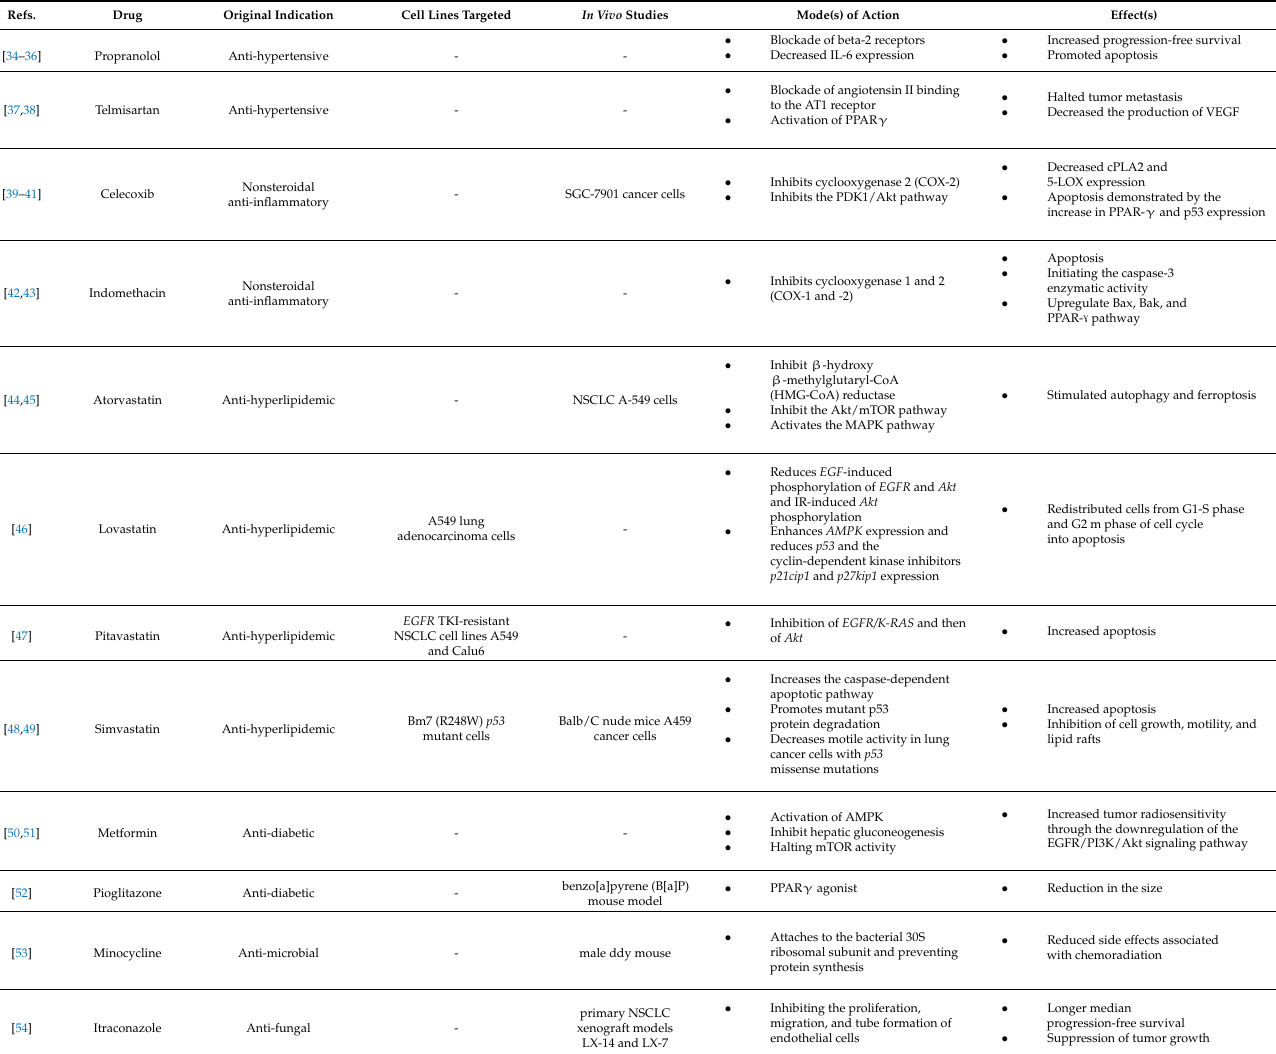
Table 1. Summary table of the drugs that have been repurposed to be used in NSCLC in pre-clinical